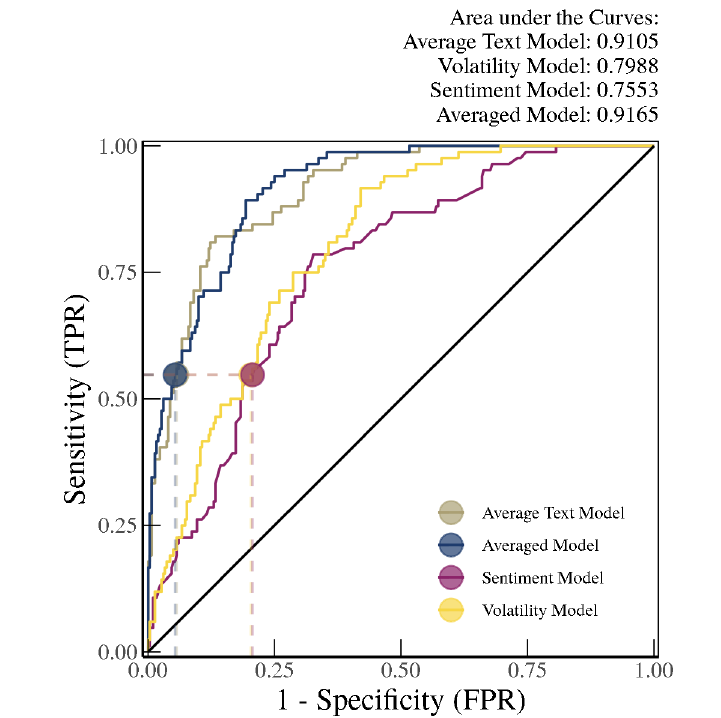
Figure 7. Results for R&R Minor Crises on OECD Text . Note: This figure shows the receiver operating characteristic (ROC) curves for our out-of-sample period (2005–2012) for models trained on the period 1981–2004 using OECD text based on Romer and Romer (2017) 5+ severity. The results show that the Average Text Model (based on the average of our SVM Radial and Random Forest text-based machine learning models) outperforms both the Volatility (volatility-based) and Sentiment (sentiment score-based) Models, with an area under curve of 0.9105. The Averaged Model (averaged across the Average Text Model, Volatility Model, and Sentiment Model) performs best, with an area under the curve of